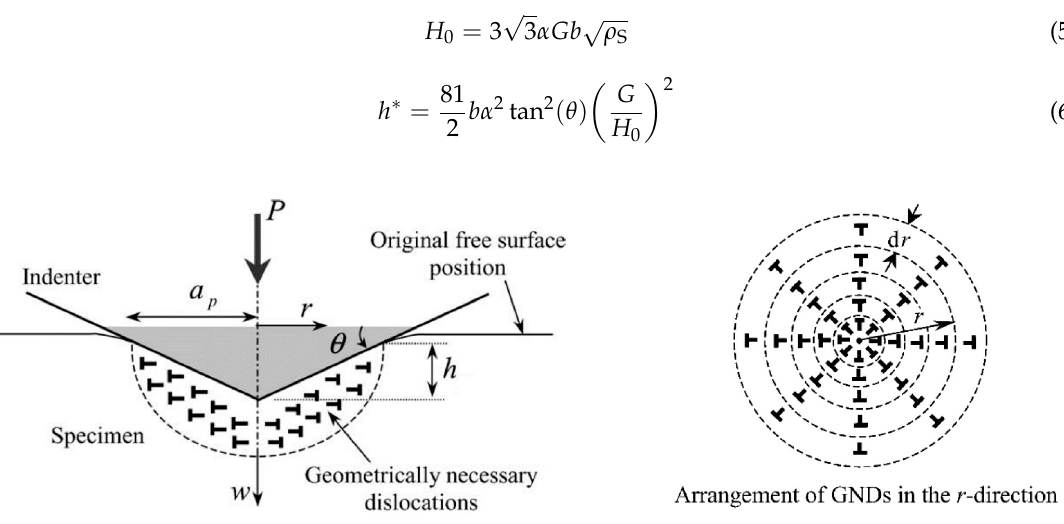
Figure 2. Axisymmetric rigid conical indenter. Geometrically necessary dislocations (GNDs) created during the indentation process. The dislocation structure is idealized as circular dislocation loops (after Abu Al-Rub and Voyiadjis [97]).